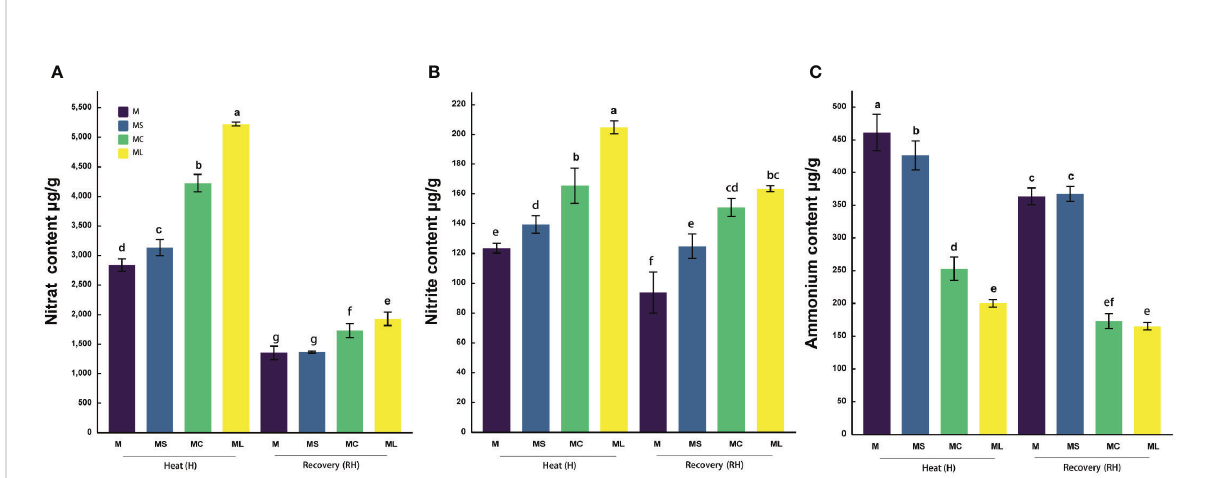
FIGURE 5 Nitrogen metabolite content. Values are the mean (± SE) of three replicates. Different letters indicate statistically signi fi cant differences between the treatment groups ( P< 0.05). (A) Nitrate content. (B) Nitrite content. (C) Ammonium